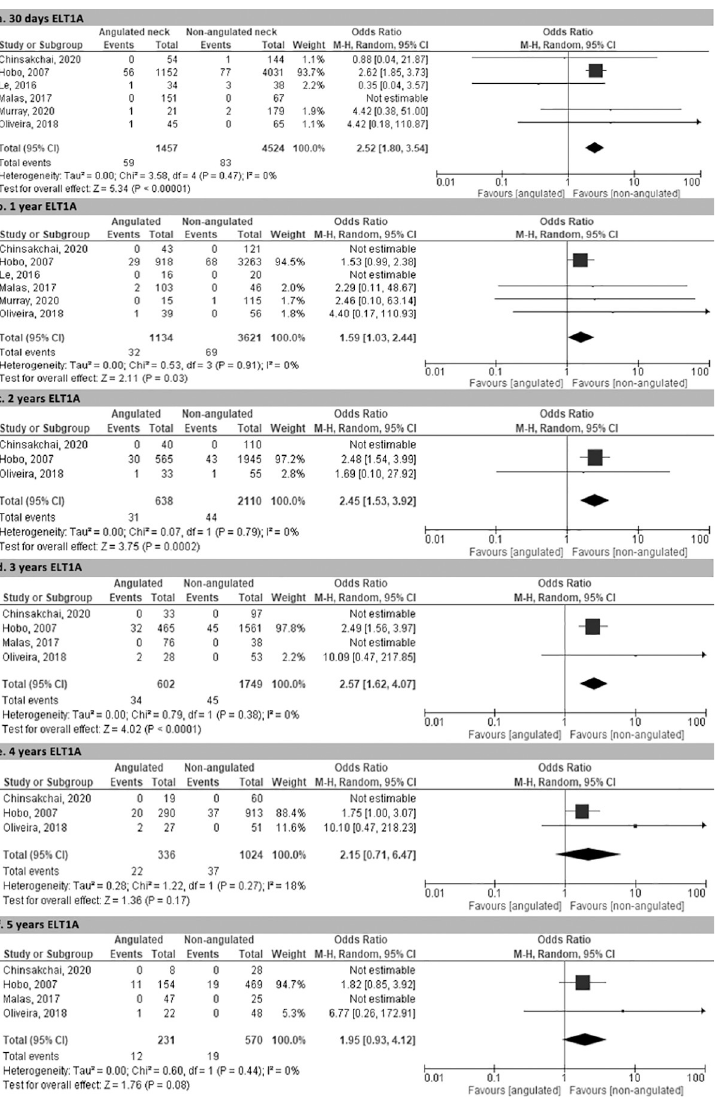
Fig 2. Rate of endoleak type 1A. Rate of endoleak type 1A at 30 days (a), 1 year (b), 2 years (c), 3 years (d), 4 years (e) and 5 years (f).